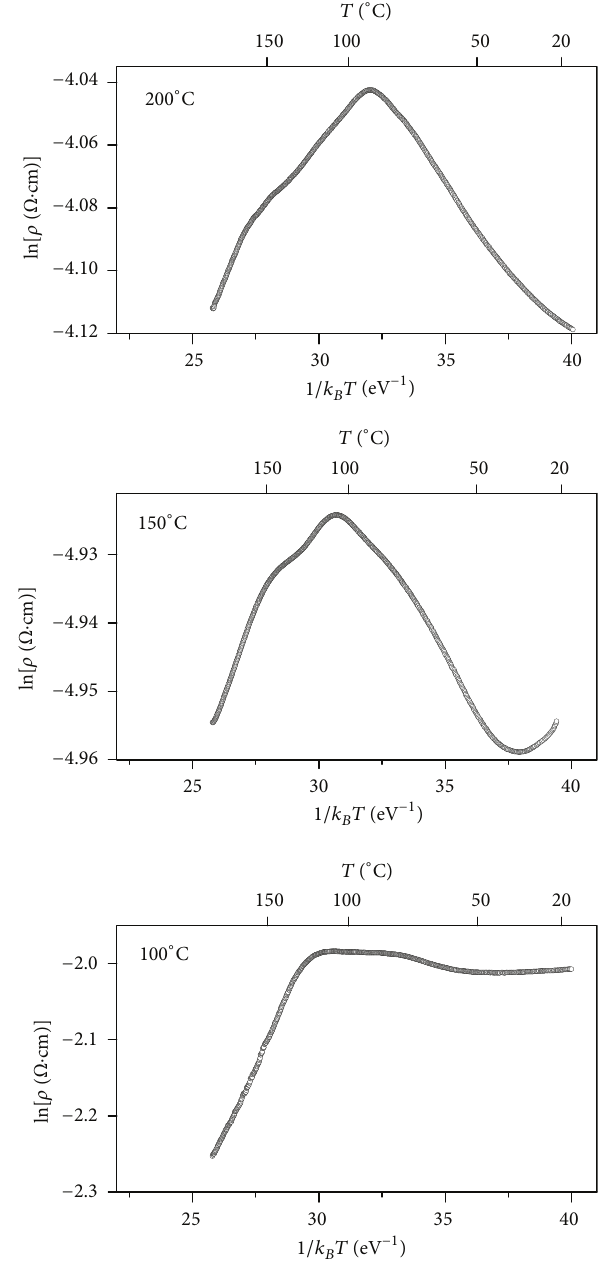
Figure 6: Reciprocal temperature dependence of electrical resistiv- ity of CuS thin films annealed in vacuum at 100, 150, and 200 ∘ C.